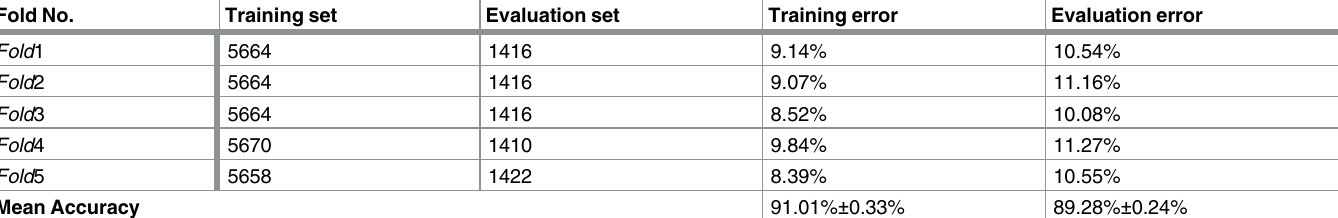
As seen from Table 3, the mean accuracy for training of 5 types of RBC classification under different folds is 91.01%, and the mean evaluation accuracy is 89.28%. Here, in order to better visualize the discriminative capability of the training deep CNNs model for RBC classification and investigate the sensitivity of the deep CNN model to various RBC categories, the Receiver Operating Characteristic (ROC) curve was used to plot the true positive rate (TPR) against false positive rate (FPR) for different classes of the 5-fold test. The top-left corner of a ROC Table 3. 5-fold cross validation for 5 types of SCD RBC classification. Fold